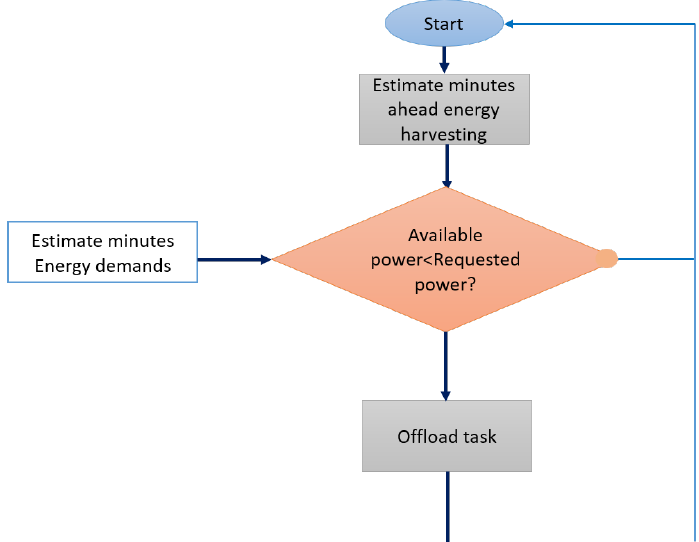
Figure 4. Principles of energy-aware offloading algorithm.